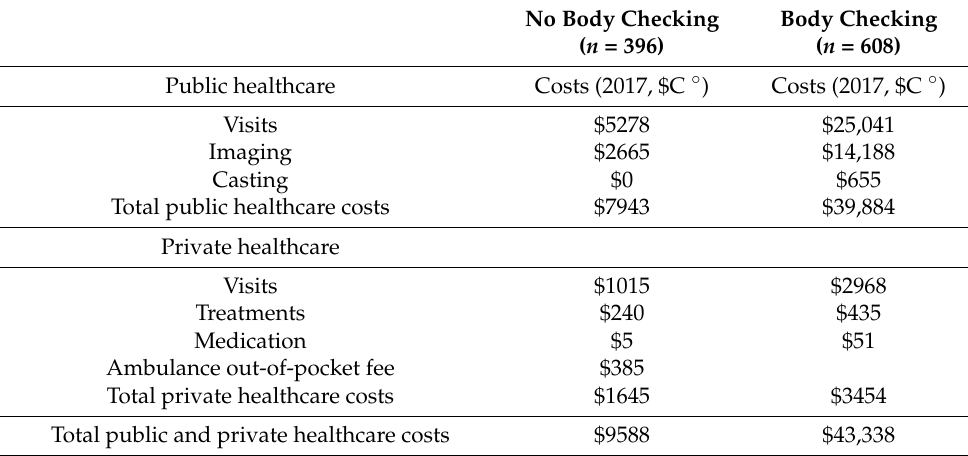
Table 4. Healthcare cost comparison between body checking policy group and by